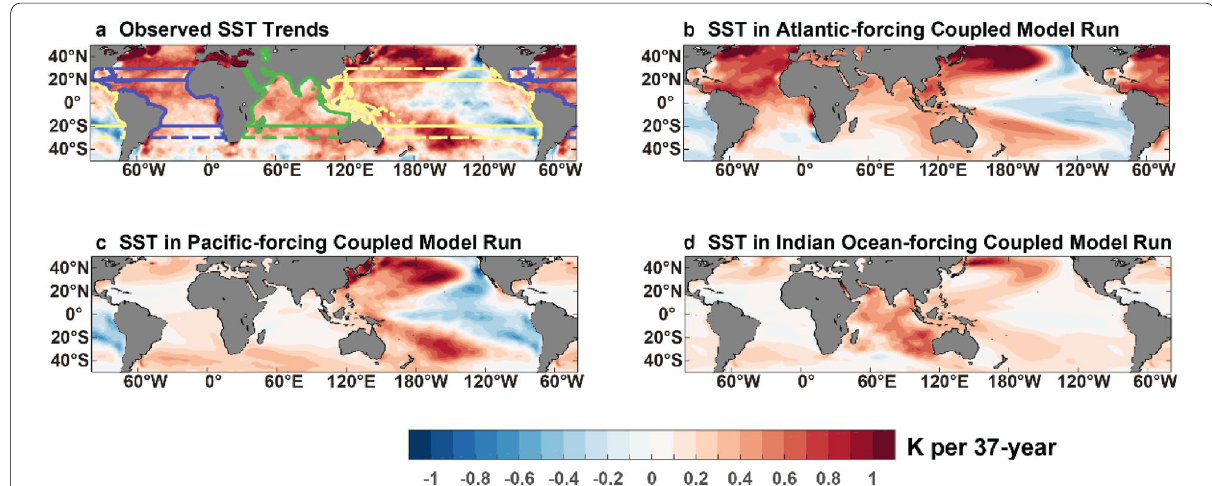
Fig. 2 The observed and the simulated changes of the tropical SST from 1979 to 2015. a shows the observed SST changes in the Hadley SST dataset, with the blue, green and yellow contours indicating the forcing area of the Atlantic‑, the Indian Ocean‑ and the Pacific‑atmospheric model simulations. b Shows simulated SST changes in the pacemaker experiment driven by the Atlantic SST forcing using the earth system model. c Shows simulated SST changes in the pacemaker experiment driven by the Pacific SST forcing using the earth system model. d Shows simulated SST changes in the pacemaker experiment driven by the Indian Ocean SST forcing using the earth system